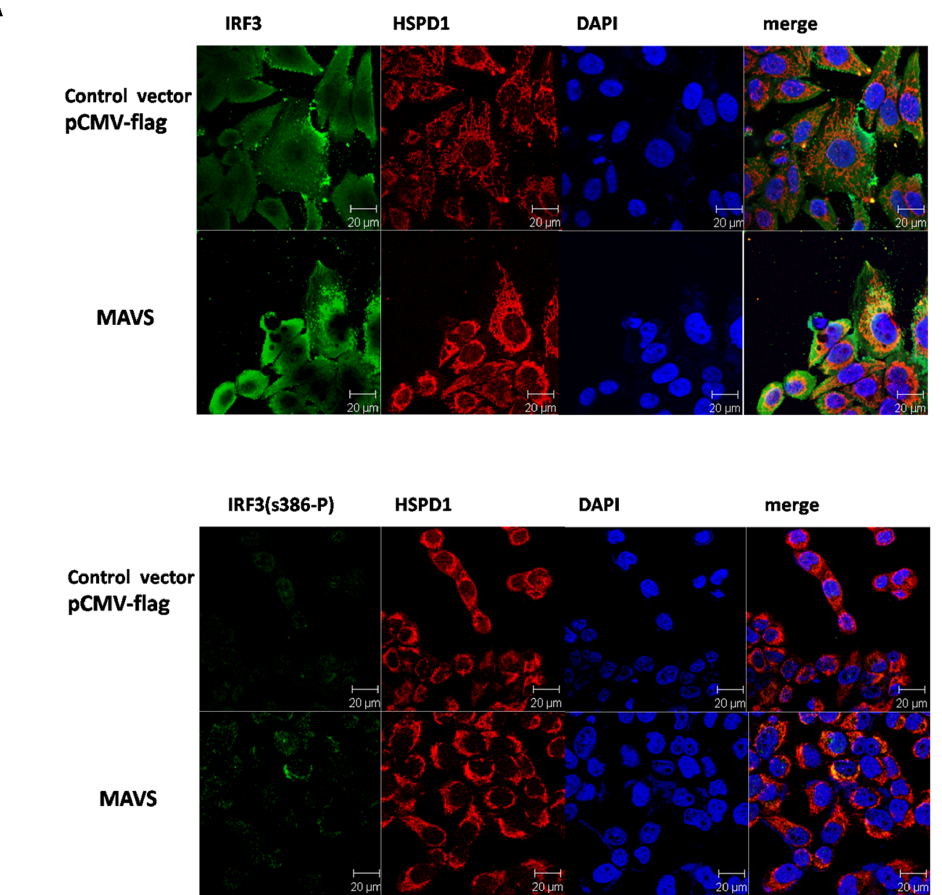
Fig. 2. Co-localization of IRF3 and HSPD1. A. HeLa cells were transfected with the MAVS or control plasmid. At 8 h post-transfection, the cells were fixed, permeabilized, and then stained with rabbit antibody against IRF3 and mouse antibody against HSPD1 and further incubated with goat anti-mouse IgG H&L (Cy3) and goat anti-rabbit IgG H&L (FITC). Nuclei were stained with DAPI. B. HeLa cells were transfected with the MAVS or control plasmid. At 16 h post- transfection, the cells were fixed, permeabilized, and then stained with rabbit antibody against IRF3 (phospho S386) and mouse antibody against HSPD1 and further developed with goat anti-mouse IgG H&L (Cy3) and goat anti-rabbit IgG H&L (FITC). Nuclei were stained with